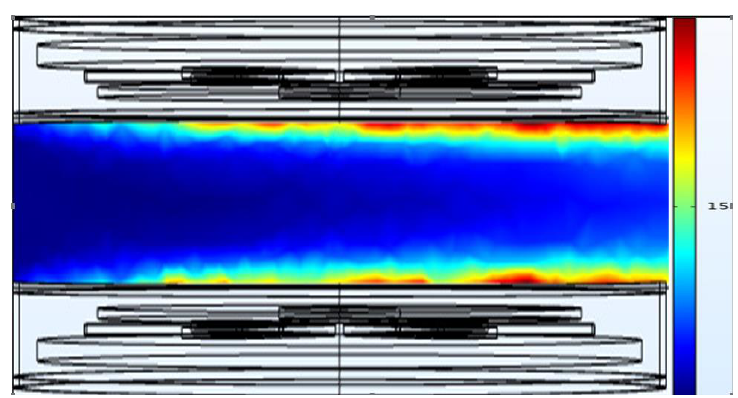
Figure 12. Thermal field distribution between coupled coils (2).